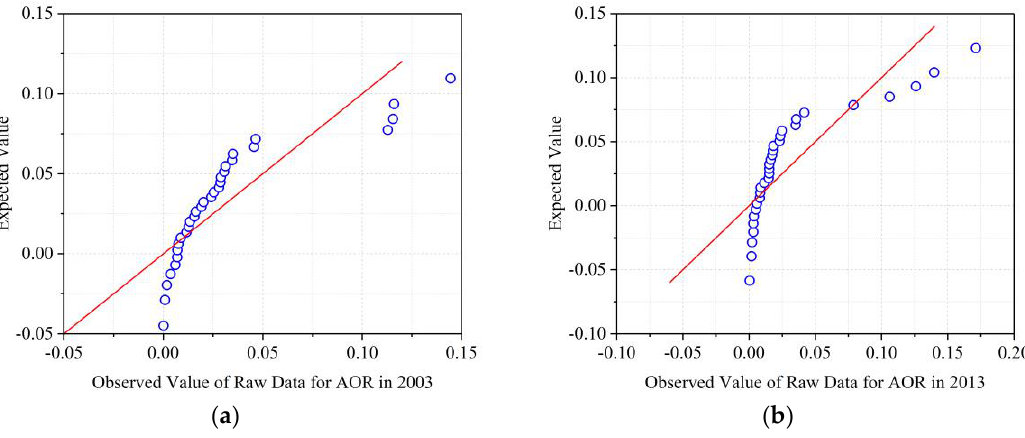
Figure 1. Normal Q-Q plots: ( a ) raw data for AOR of natural wetlands in 2003; ( b ) raw data for AOR of natural wetlands in 2013.